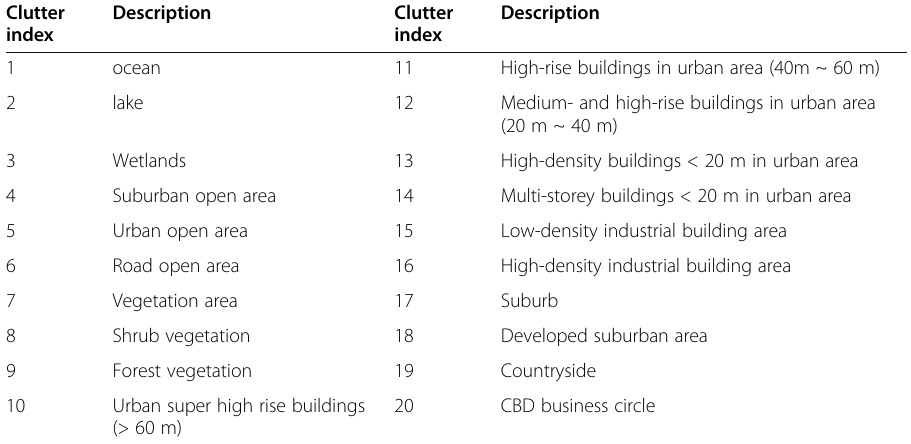
Table 3 Number meaning of feature type